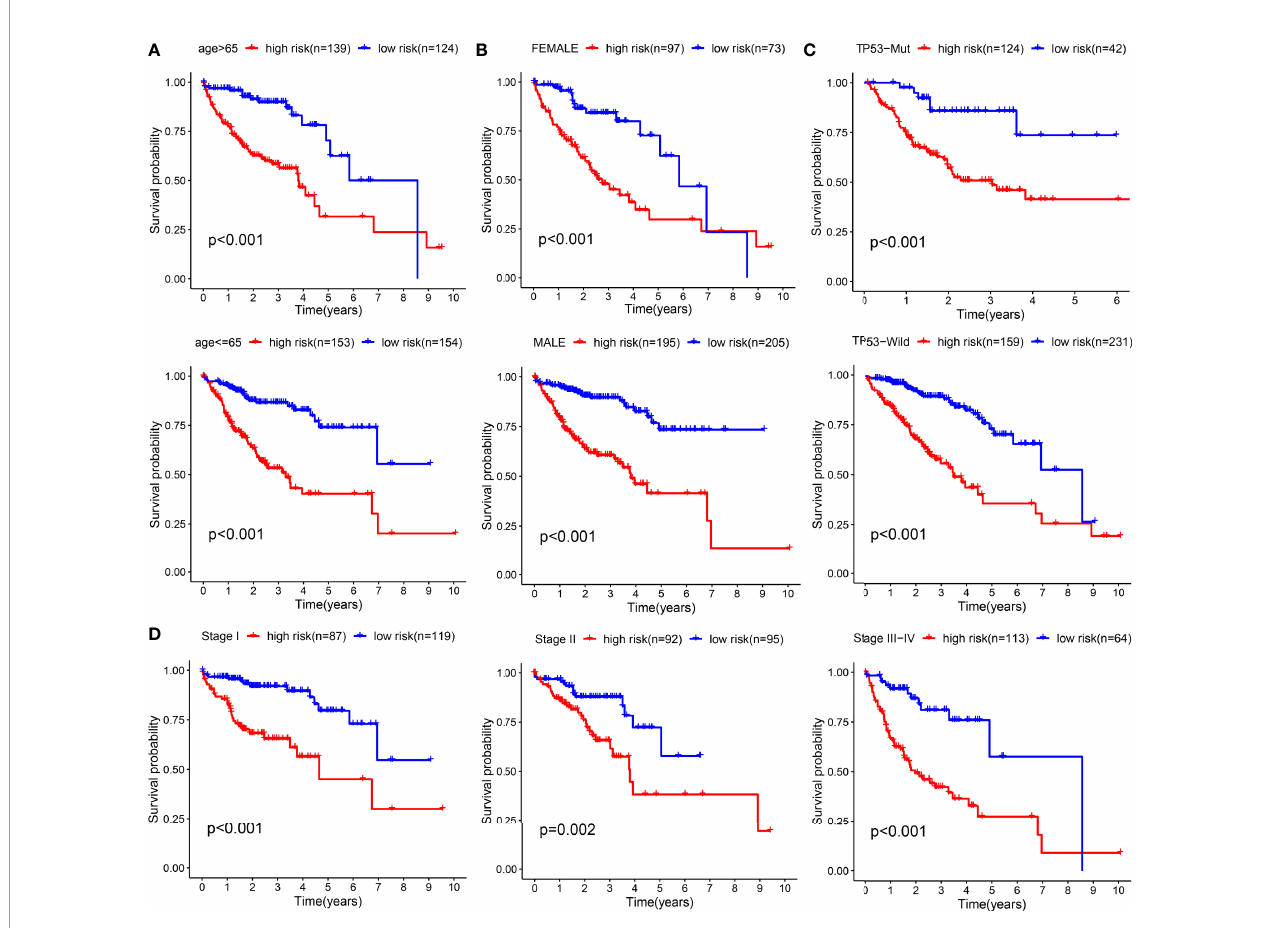
FIGURE 10 | Subgroup Kaplan – Meier survival analysis according to different clinical features in all included HCC patients (A) Age (B) Gender (C) TP53 (D)